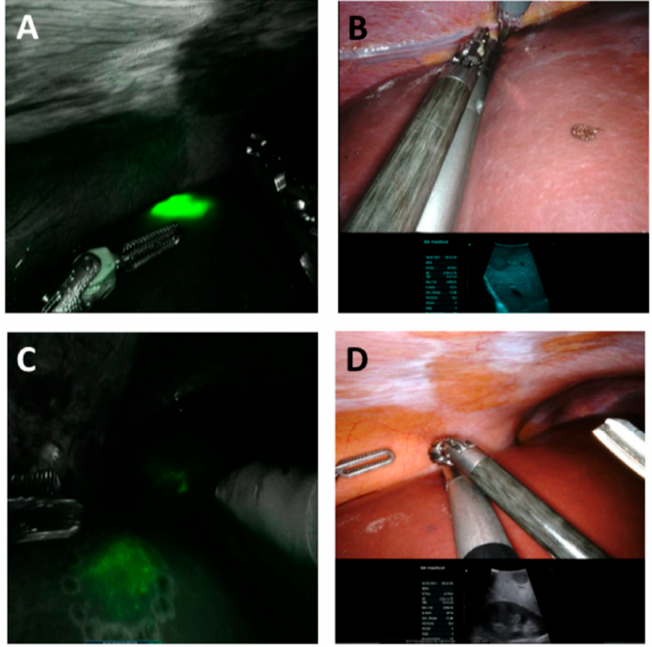
Figure 2. Intra-operative near-infrared image ( A , C ) and normal white light image ( B , D ) with the corresponding image of the IOUS of unequivocal staining ( A , C ) of a HCC, corresponding with the IOUS (HCC) and diffuse staining and not corresponding with the ICG-based image ( C , D ) of a